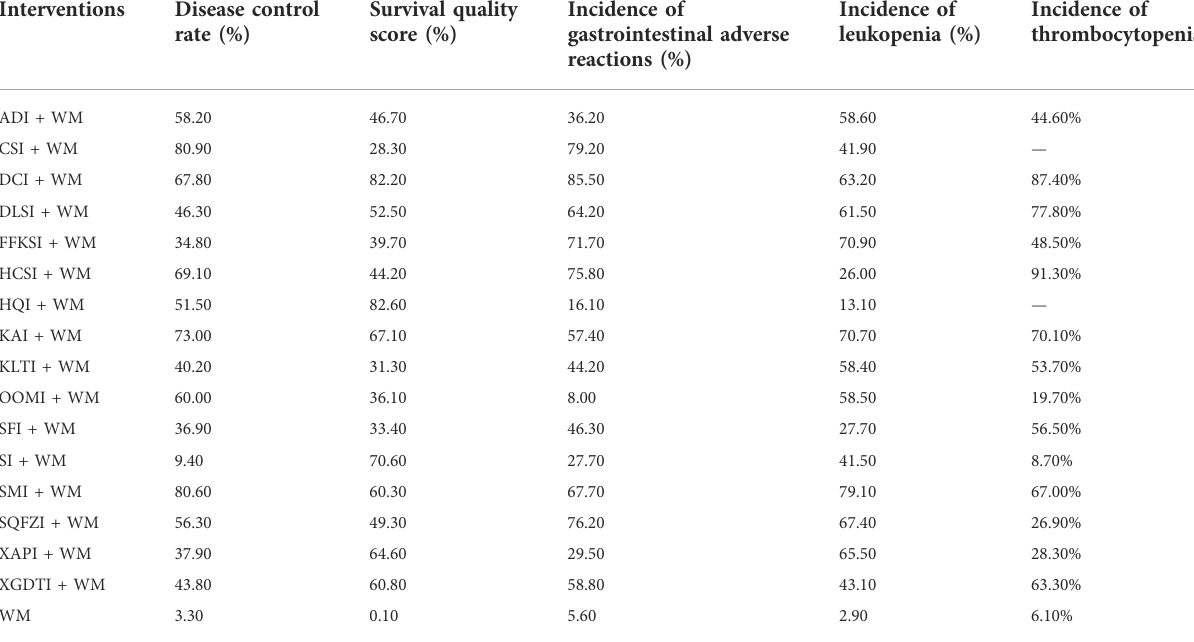
TABLE 3 Surface under the cumulative ranking probabilities analysis (SUCRA) results for fi ve outcome measures.